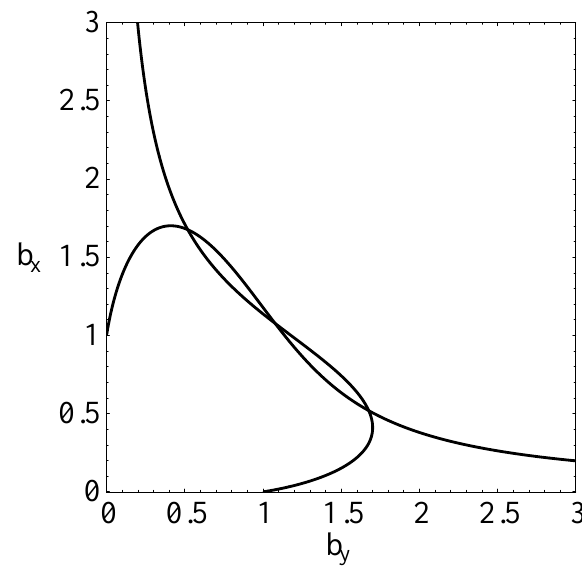
FIG. 1. Graphical method for solving Eqs. (12) on self- consistent b functions. Intersection on the primary diagonal corresponds to the equal solutions, additional intersections describe the flip-flop solutions.